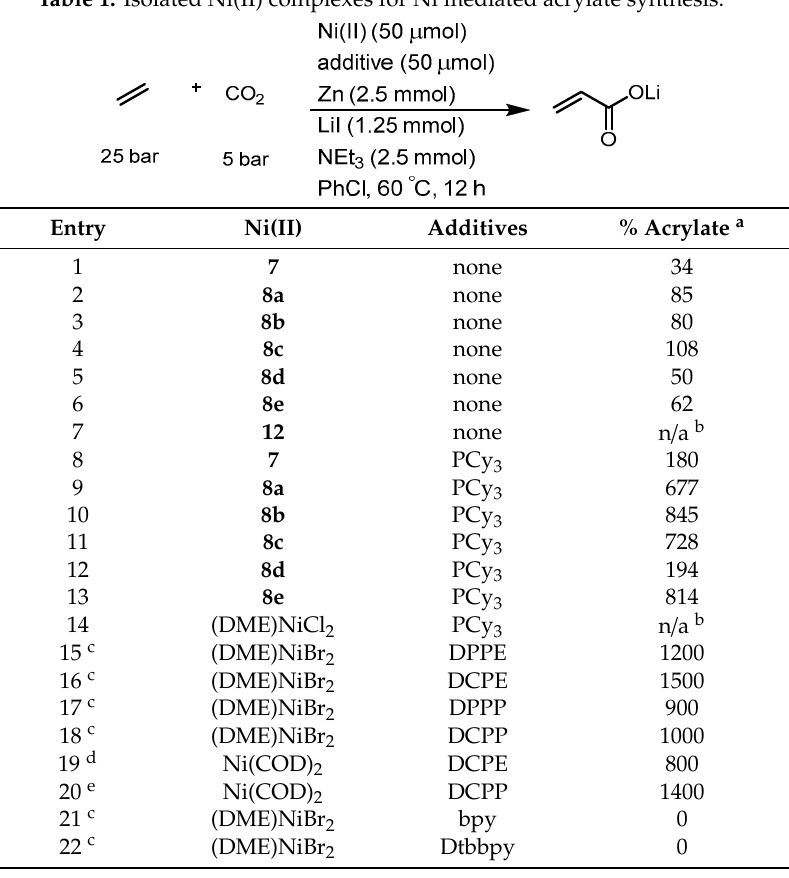
Table 1. Isolated Ni(II) complexes for Ni mediated acrylate synthesis.